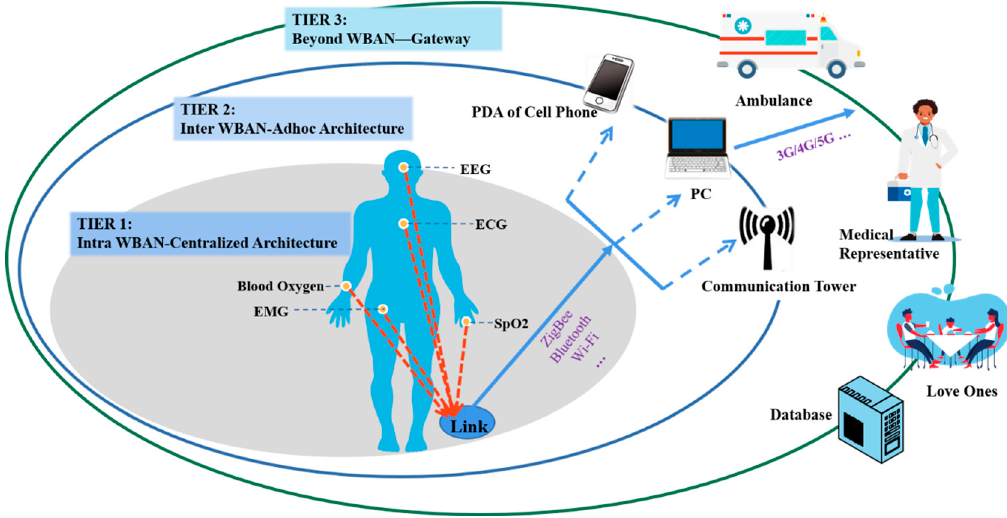
Figure 2. The architecture of the WBAN